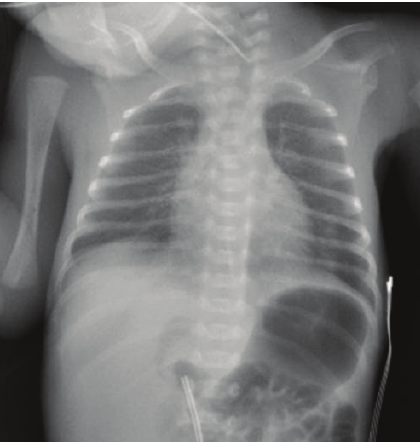
Figure 1: Chest radiograph (first day of life) revealing diffuse hazi- ness of both lungs.